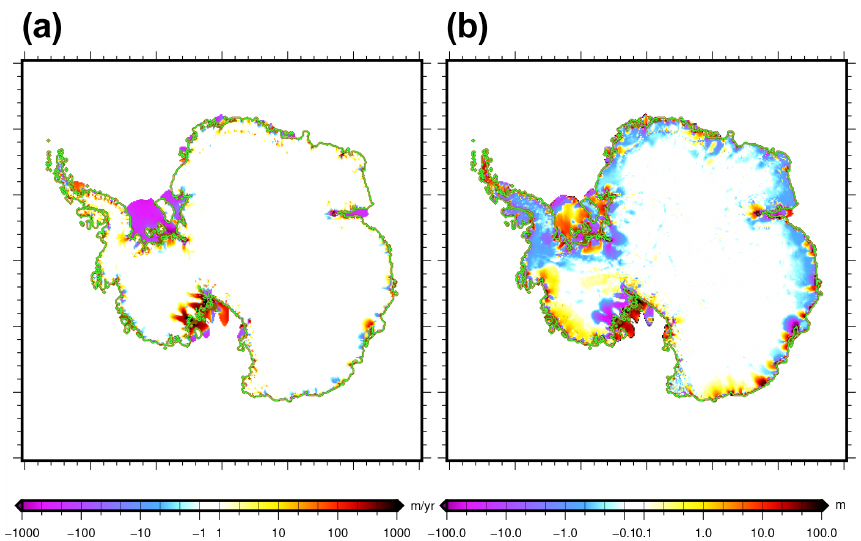
Figure 13. (a) Simulated surface velocity change during the projection run (2096–2100 with respect to 2015–2019) using NorESM1-M forcing under RCP8.5 with a medium oceanic sensitivity. (b) Change in the dynamical contribution to ice thickness change in 2100 (see text for definition) for this same experiment. For both panels, we corrected the changes using the ones simulated in the control experiment ctrl_proj over the same period. The ranges − 1 to 1myr − 1 and − 0 . 1 to 0.1m are set to white in (a) and (b) ,